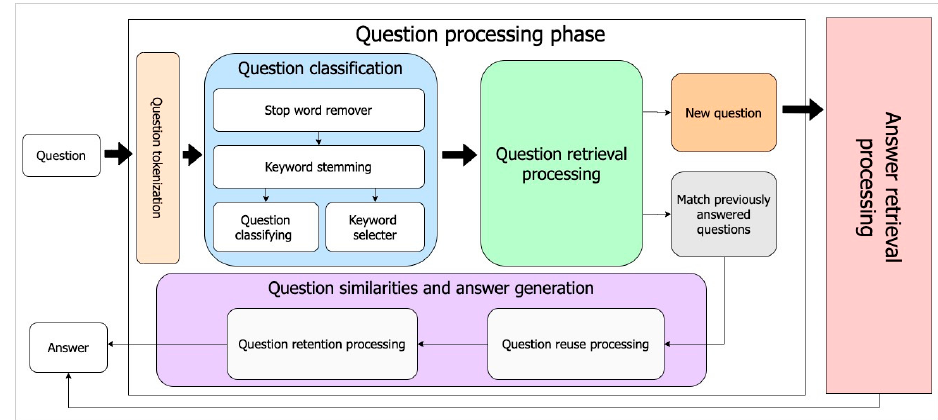
Figure 2. The system framework in part of the question-processing phase.